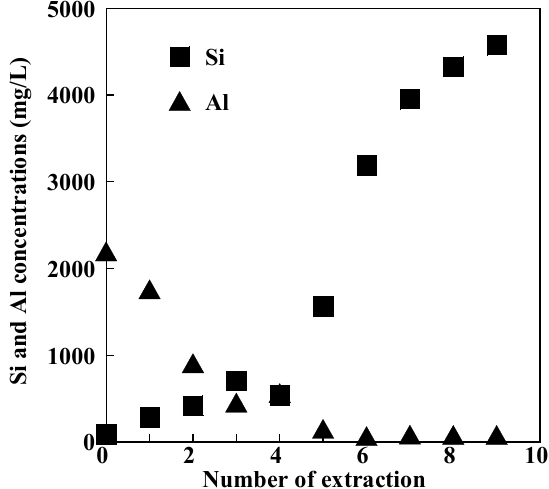
Figure 7. Concentrations of Si and Al in NaOH solutions after zeolite synthesis.